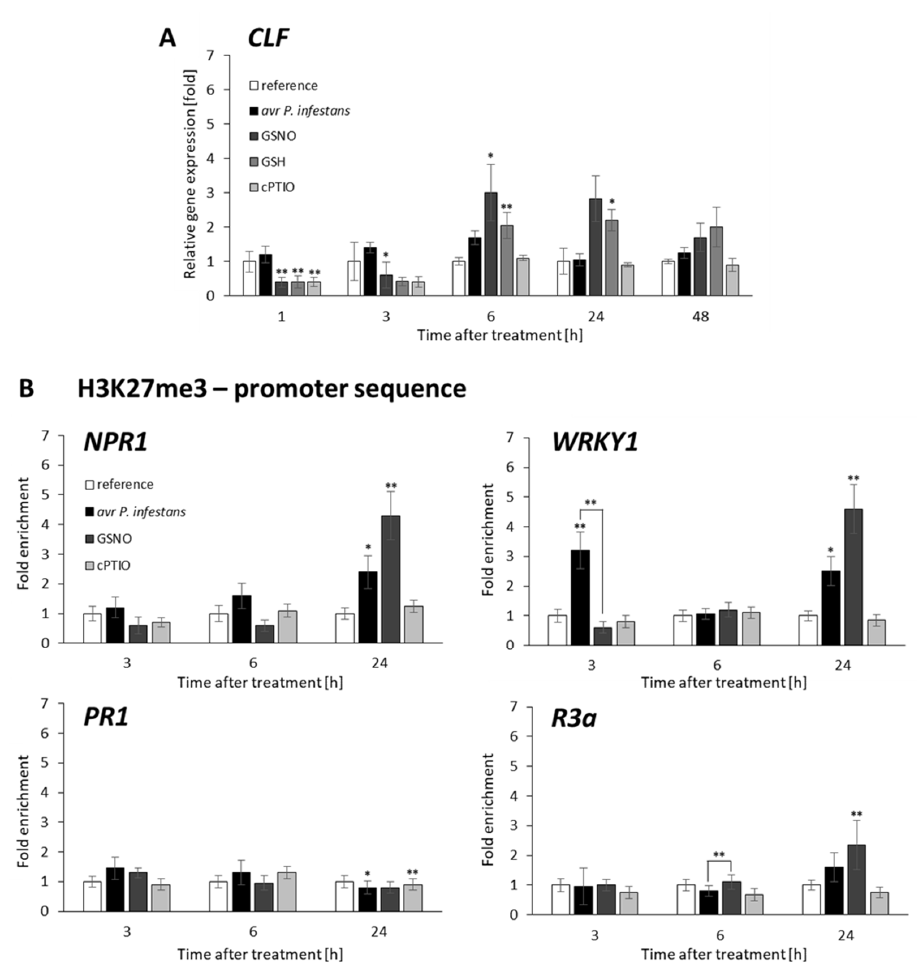
Figure 3. CLF methyltransferase expression profile ( A ) and distribution levels of H3K27me3 on the promoter of NPR1 , WRKY1 , PR1 , and R3a , respectively ( B ). RT-qPCR gene expression of CLF was analyzed in potato leaves (at 1–48 h) after treatment with GSNO, GSH, cPTIO, water, or avr P. infestans inoculation, respectively. ChIP–qPCR analyses were performed in potato leaves at selected time points (3–24 h), after treatment with GSNO, GSH, cPTIO, water, or avr P. infestans inoculation, respectively. Data are presented as X-fold enrichment [55]. The relative amount of immunoprecipitated chromatin fragments (as determined by real-time PCR) from the above variants of treatment was compared with the reference (arbitrarily set to 1). Each experiment included at least three independent measurements per sample. P values for each sample combination were calculated using ANOVA and mean values were compared using the Tukey–Kramer test ( α = 0.05 (*) and α = 0.01 (**)).